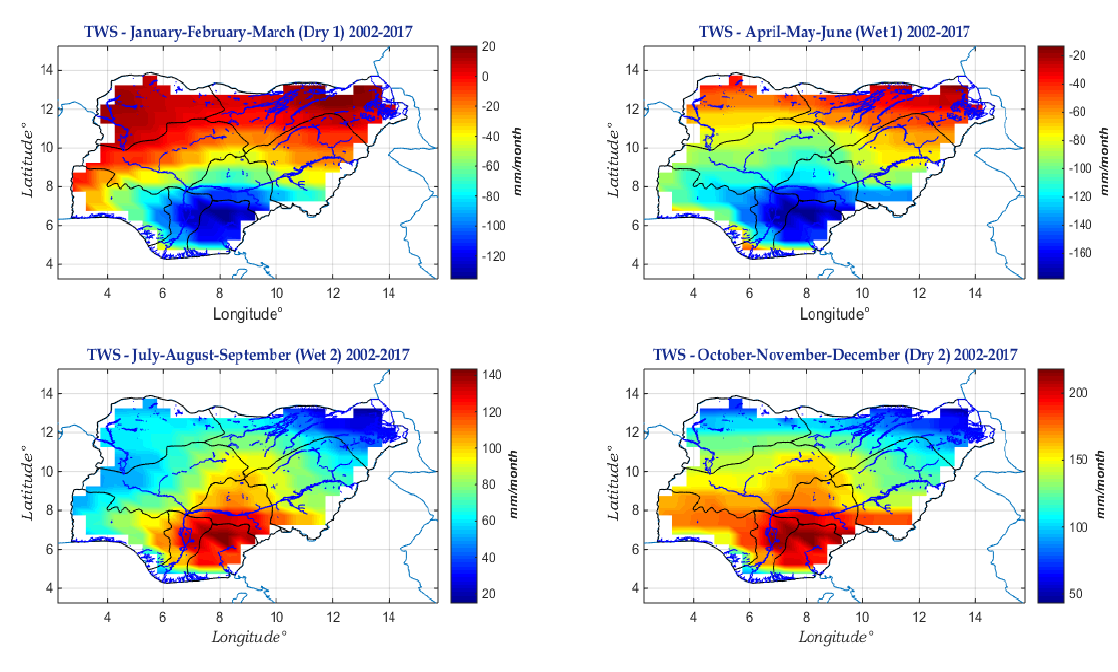
Figure 4 . Spatial Seasonal Patterns of TWS over Nigeria (2002-